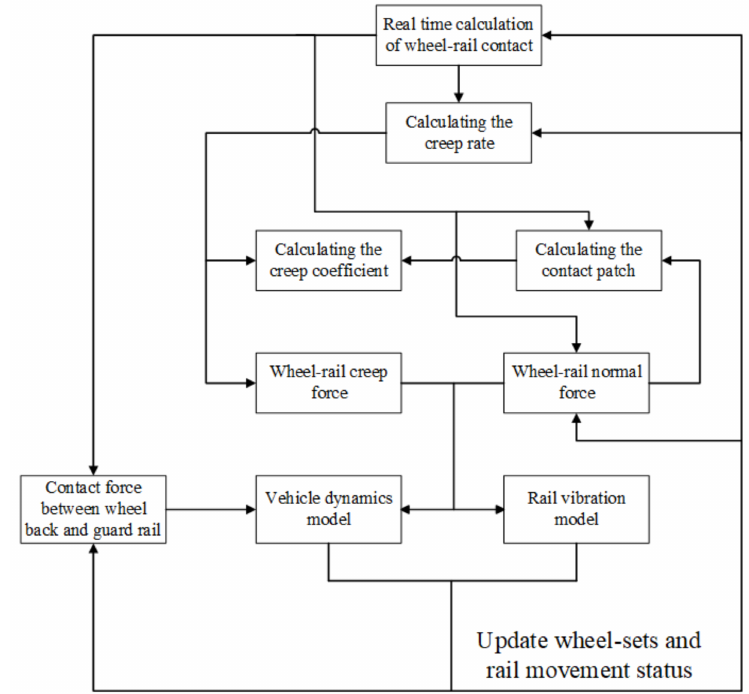
Figure 5. Calculation process of wheel/rail interaction.